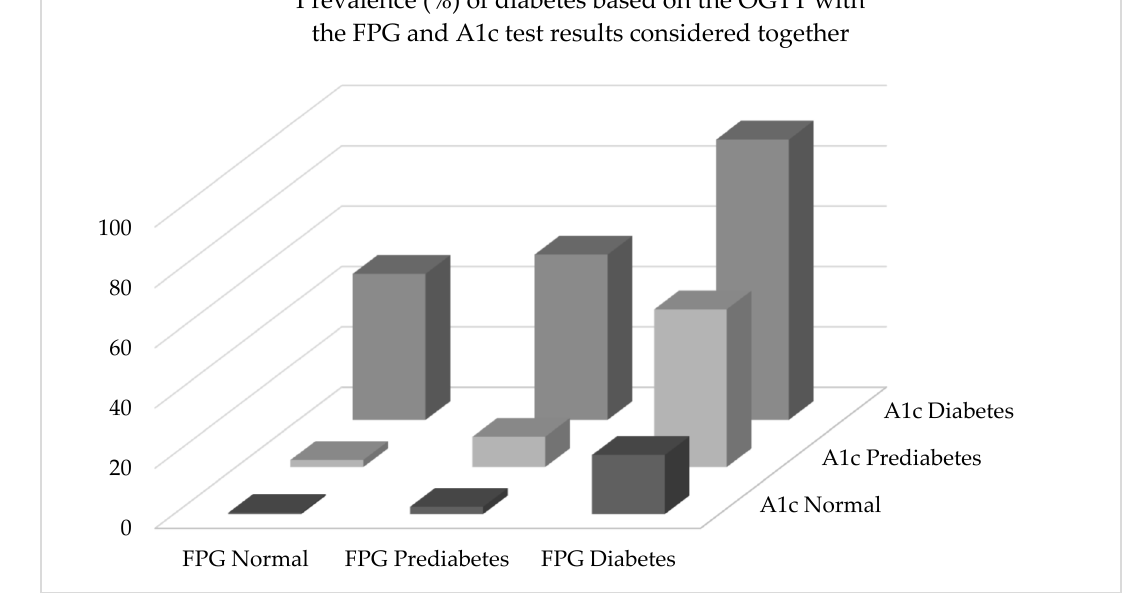
Figure 1. For the 2-h OGTT, “Normal” was defined as a plasma glucose level of < 140 mg / dL ( < 7.8 mmol / L), “Prediabetes” was 140–199 mg / dL (7.8–11.0 mmol / L), and “Diabetes” was a glucose level ≥ 200 mg / dL (11.1 mmol / L). For the FPG (fasting plasma glucose) assessment, “Normal” was < 100 mg / dL ( < 7.0 mmol / L), “Prediabetes” was 100–125 mg / dL (5.6–6.9 mmol / L), and “Diabetes” was defined as a glucose level ≥ 126 mg / dL ( ≥ 7.0 mmol / L). For the A1c test, “Normal” was < 5.7% ( < 39 mmol / mol), “Prediabetes” was 5.7–6.4% (39–47 mmol / mol), and “Diabetes” was an A1c ≥ 6.5% ( ≥ 48 mmol /